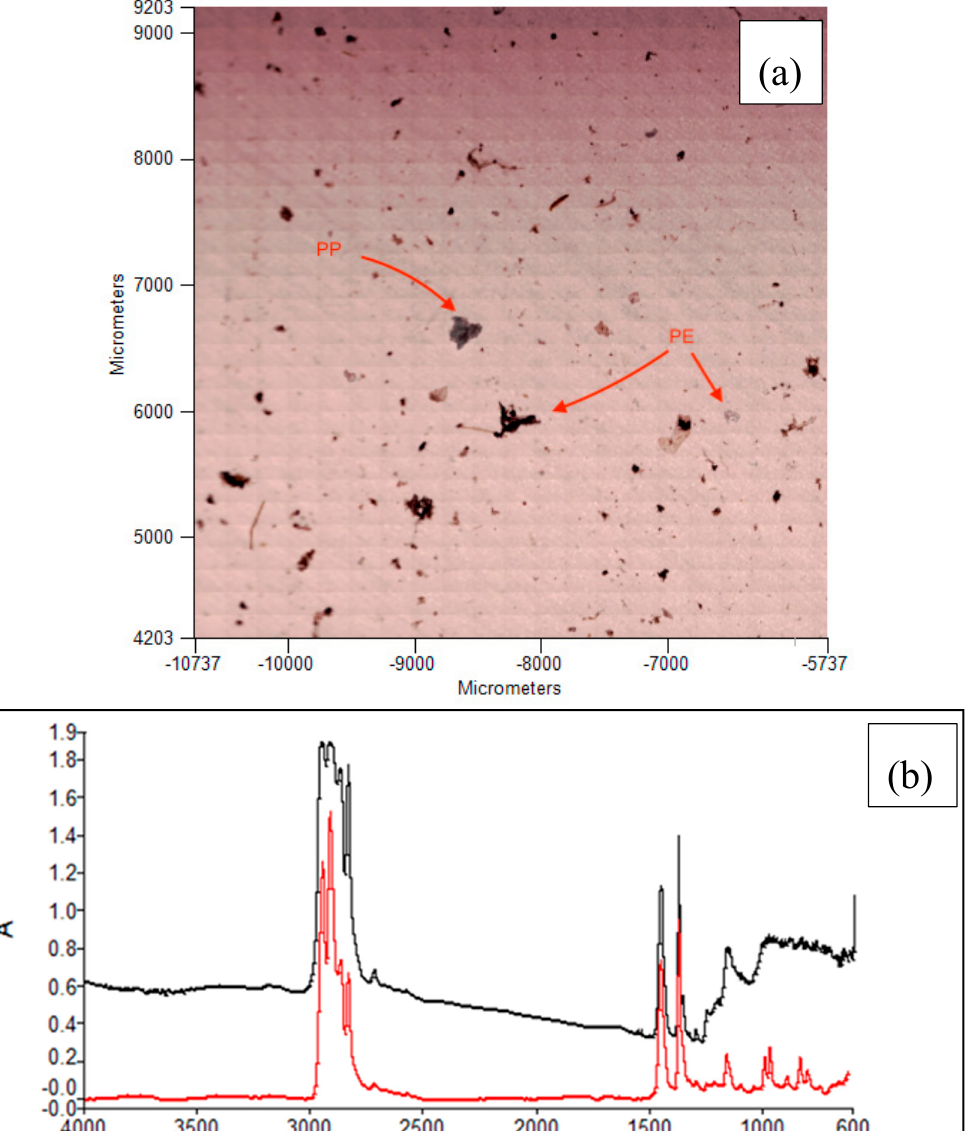
Figure 6. ( a ) Image of microparticles using FTIR microscopy from the lake sample. Red arrows indicate the microplastics and ( b ) spectrum (absorbance versus wavelength in cm − 1 ) of a PP microplastic (black) and PP reference spectra of the library (red).